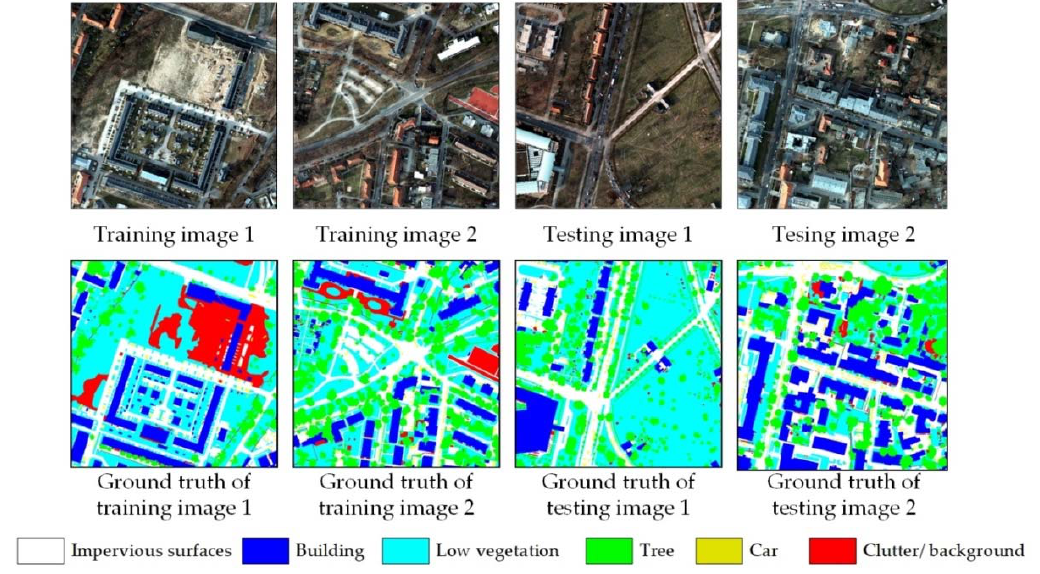
Figure 10. The study images and their corresponding ground truth from the Potsdam dataset.